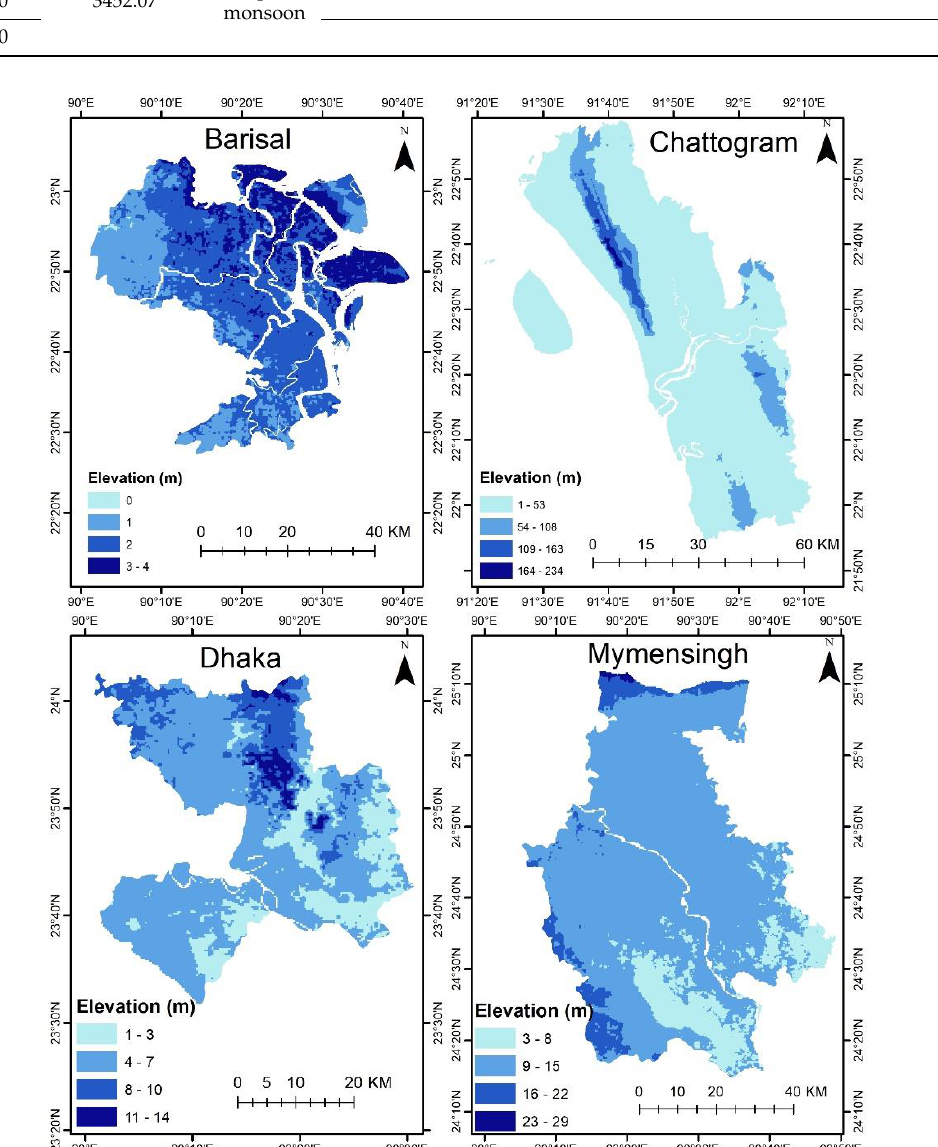
Figure 2. Study area showing four districts, namely Barisal, Chattogram, Dhaka, and Mymensingh, in Bangladesh among seven major districts (digital elevation model) .